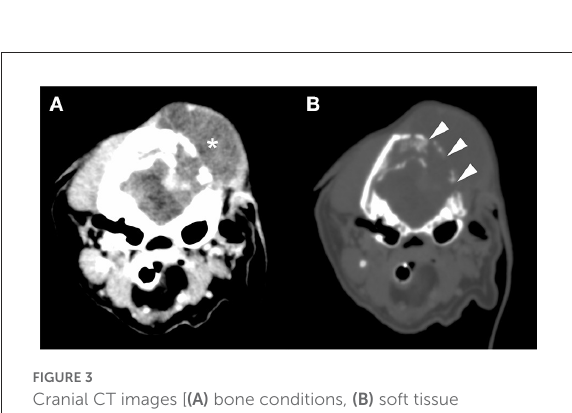
FIGURE3 Cranial CT images [ (A) bone conditions, (B) soft tissue conditions]. Contrast-enhanced CT image of the head. Soft tissue mass formation was observed mainly in the left temporal-occipital region (*). Furthermore, the region showed destruction of the occipital bone (arrowhead) and an unclear boundary with the brain parenchyma. No obvious metastatic findings were found in the chest or abdomen. CT, computed tomography.